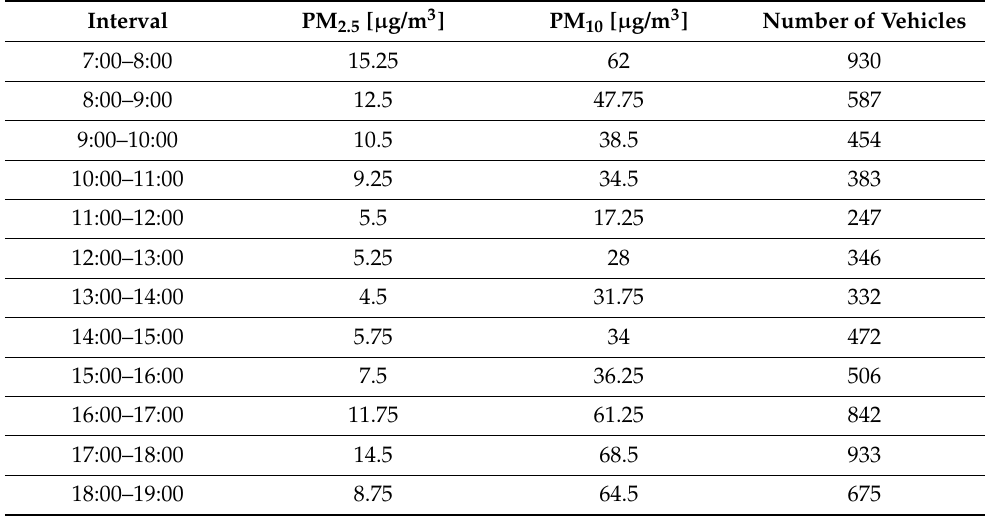
Table 4. Hourly particulate emissions in measurement location.